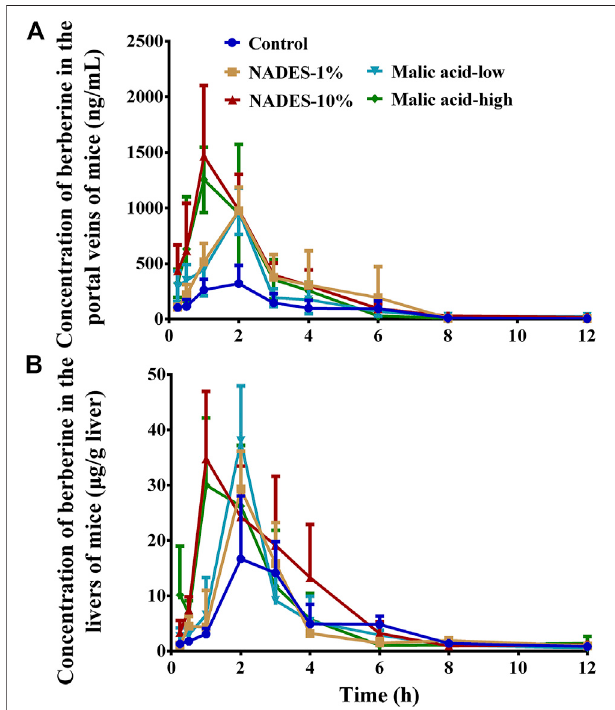
FIGURE 4 | Concentration time-curves of berberine in the portal veins (A) and livers (B) of mice that were orally administered with berberine